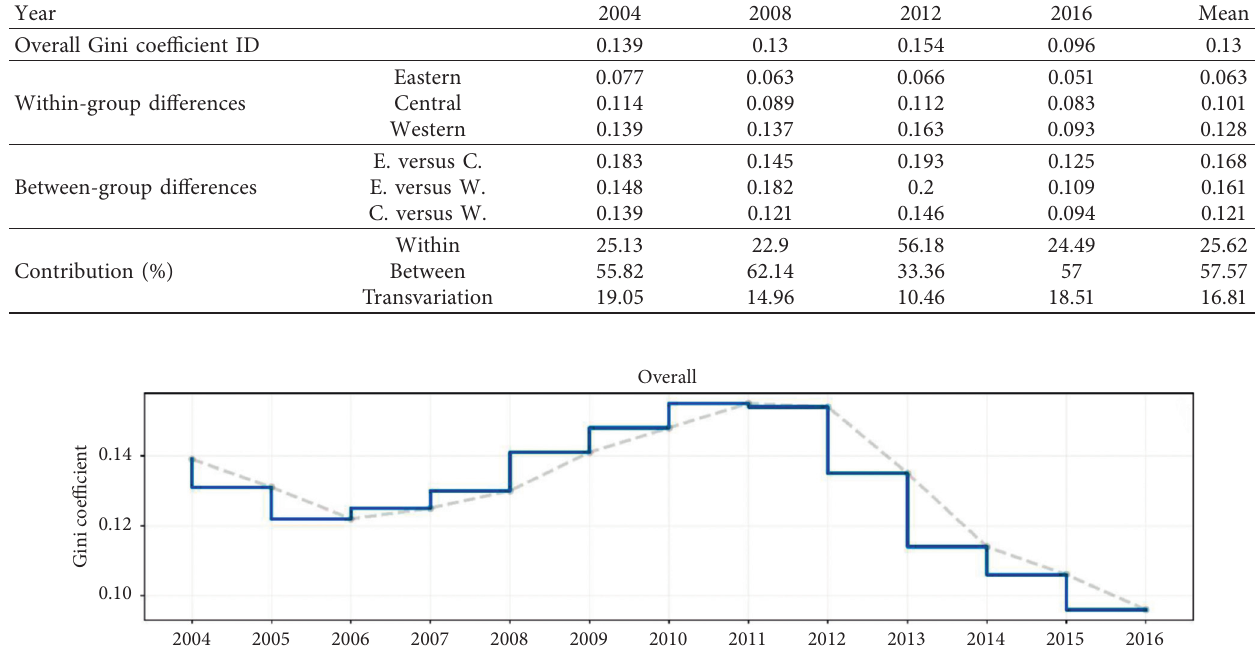
Table 4: Gini coefficient and decomposition results of urban construction land utilization efficiency.